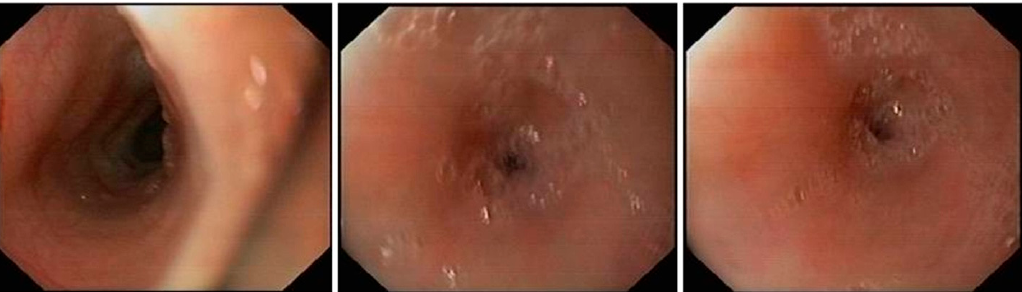
Figure 3. Endoscopy showing an esophageal web with a pinpoint orifice.